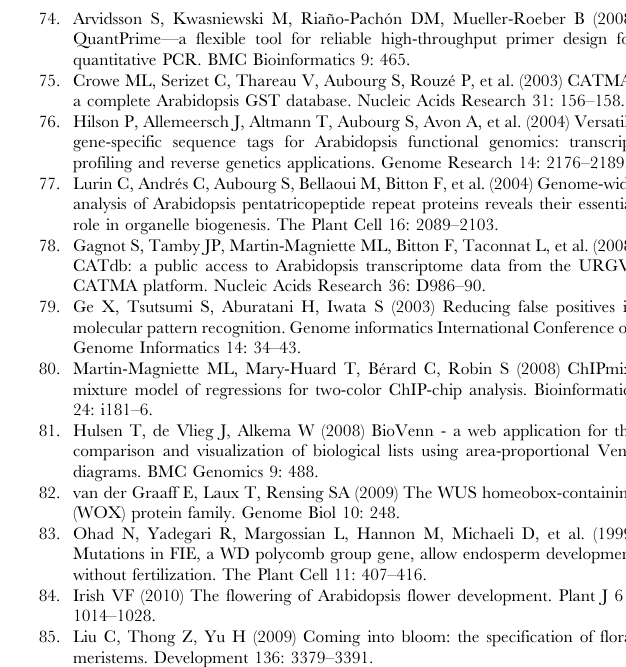
diagrams. BMC Genomics 9: 488. 82. van der Graaff E, Laux T, Rensing SA (2009) The WUS homeobox-containing (WOX) protein family. Genome Biol 10: 248. 83. Ohad N, Yadegari R, Margossian L, Hannon M, Michaeli D, et al. (1999) Mutations in FIE, a WD polycomb group gene, allow endosperm development without fertilization. The Plant Cell 11: 407–416. 84. Irish VF (2010) The flowering of Arabidopsis flower development. Plant J 61: 1014–1028. 85. Liu C, Thong Z, Yu H (2009) Coming into bloom: the specification of floral meristems. Development 136: